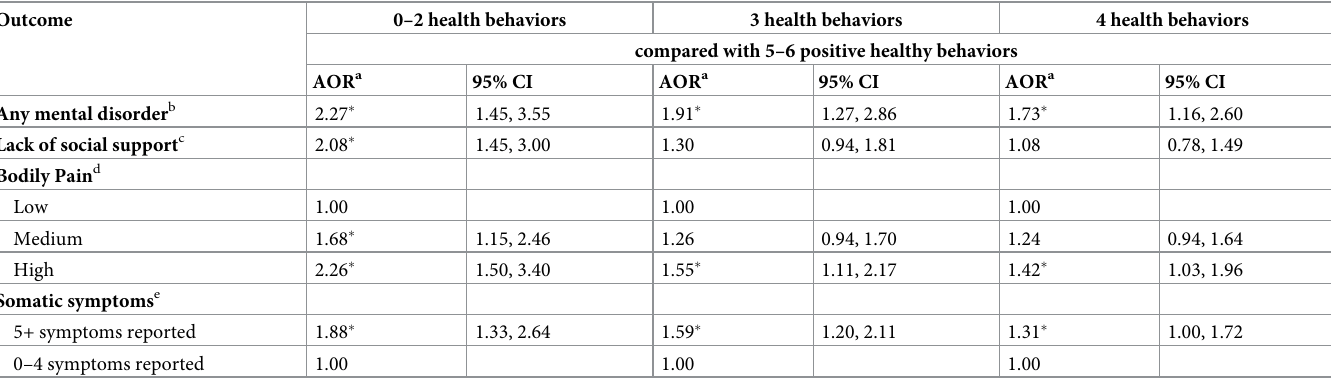
Table 5. Adjusted odds ratios of outcomes by number of healthy behaviors, all Army specializations combined among soldiers in the Millennium Cohort Study.